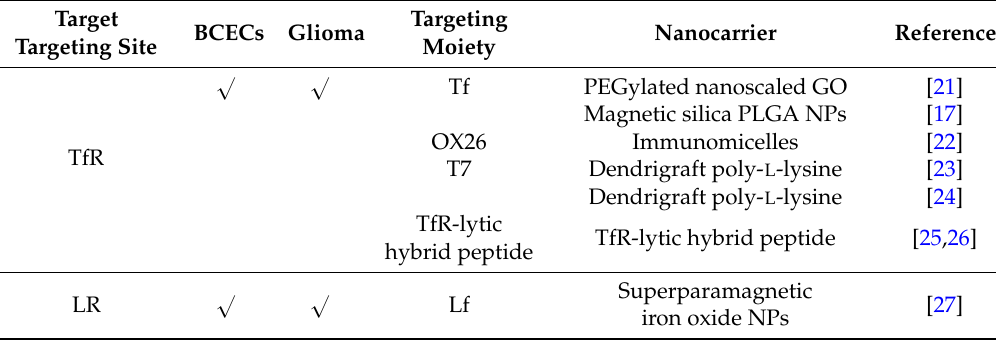
Figure 1. Schematic representation of single ligand-modified targeting systems. Table 1. Representative single ligand-modified targeting systems.